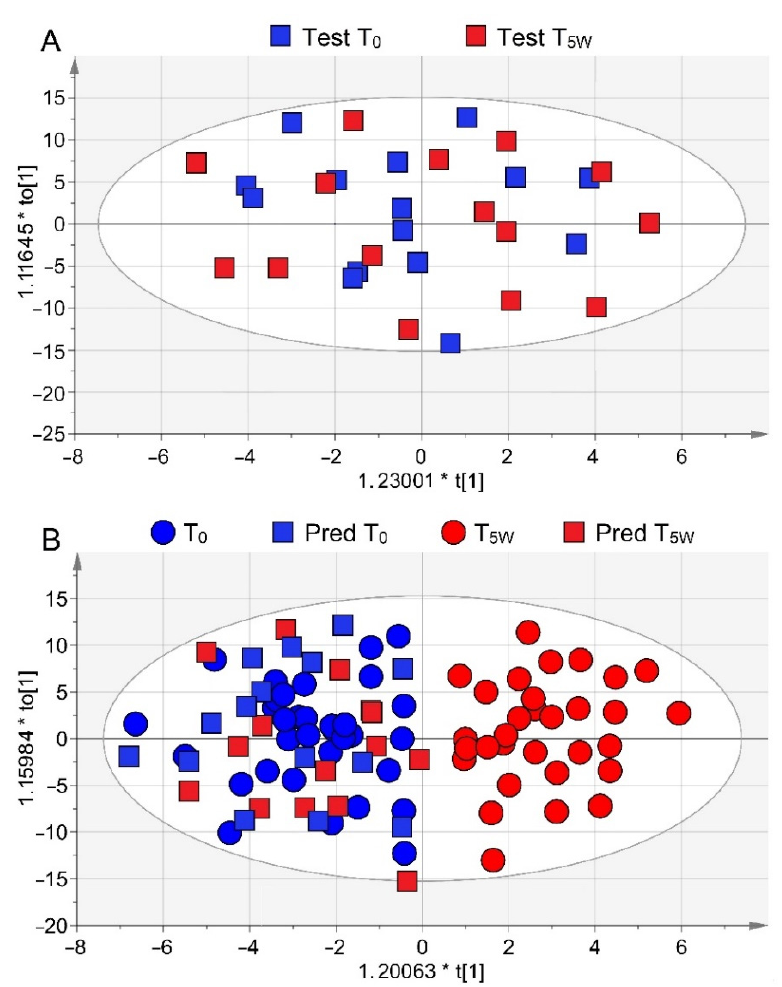
Figure 3. Validation of the T 0 –T 5W OPLS-DA model using a test set. ( A ) OPLS-DA model of the 15 patients not yet on PR. No satisfactory classification model was obtained (R 2 = 0.12 and Q 2 = 0.16), indicating that the two classes at T 0 (Test T 0 , blue squares; Test T 5W , red squares) and T 5W cannot be discriminated. ( B ) Predicted scores plot representing classification of the validation set obtained with samples projection onto the OPLS-DA T 0 –T 5W of Figure 2B. Circles represent the training set samples (T 0 , blue; T 5W , red), while squares refer to the validation set samples (Pred T 0 , blue; Pred T 5W , red). All predicted samples were correctly located at T 0 since they were stable COPD patients not on PR.